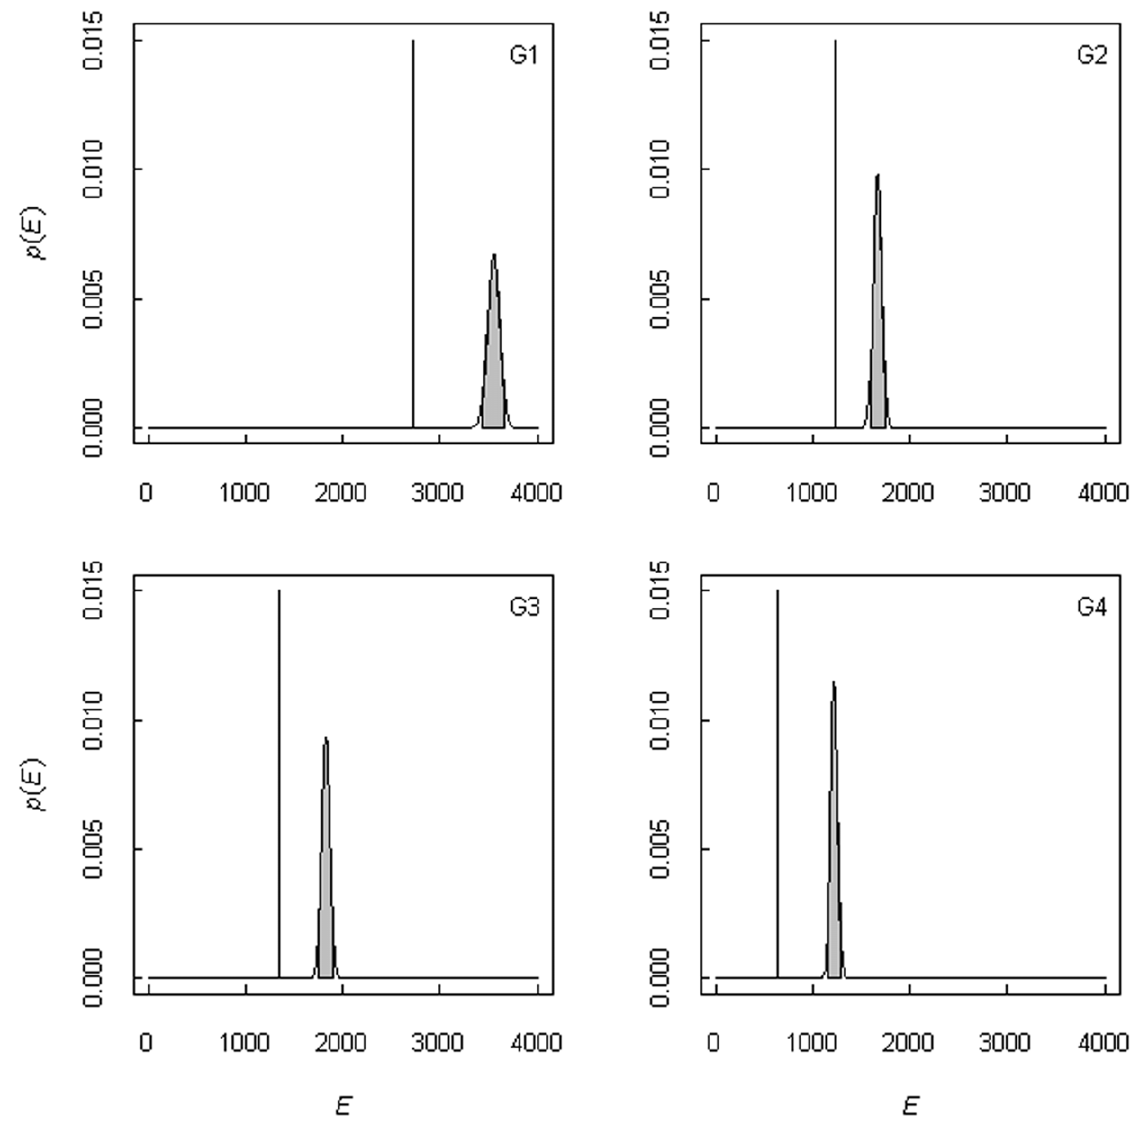
Figure 1. Distribution of expected total co-occurrences for the entire plant community in Cabo de Gata-Nı´jar. E , plant community total co-occurrences; p ( E ), probability distribution of expected total co-occurrences p ( N / E )=(1/ N !)*e - A * A * N , where N is the number of surveyed points (7503). G1 to G4 are the sampling sites and are sorted by grazing intensity (G1=0 ind ? ha 2 1 ; G2=0.27 ind ? ha 2 1 ; G3=0.46 ind ? ha 2 1 ; and G4=0.65 ind ? ha 2 1 ). Vertical lines represent A . Because the observed values are smaller and fall outside the 95% confidence interval (grey area), the community is considered to be dominated by negative associations.